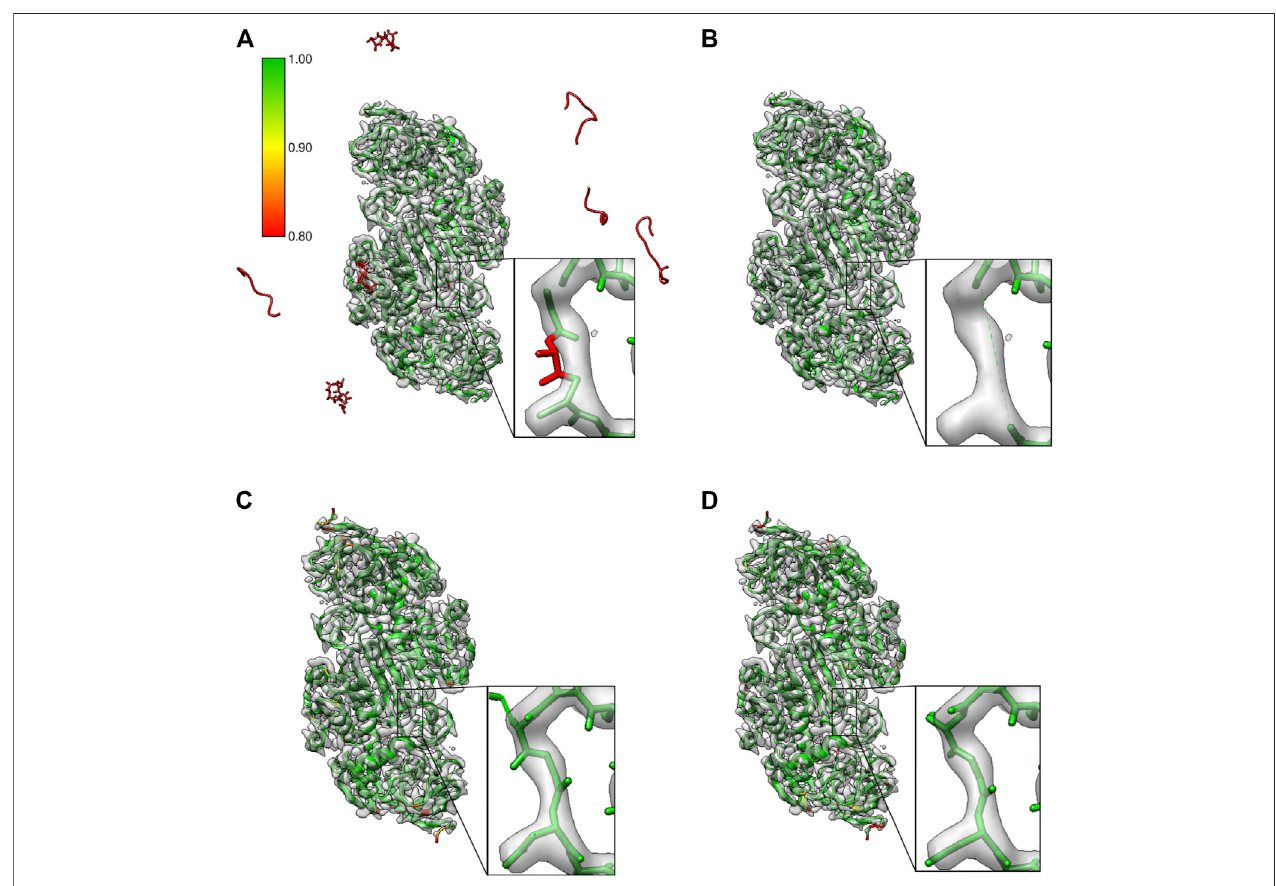
FIGURE 7 | Results from pruning the model built ab-initio with the Buccaneer software tool on the map of alcohol dehydrogenase (EMD-0406). (A) Ab-initio built model where residues associated with low con fi dence scores are in red. Potential mis fi t of residue 107 (chain A) is highlighted, and fragments built into the background noiseoutsidethemoleculardensityarealsoassociatedwithlowcon fi dencescores. (B) Modelafterpruning;themis fi ttedresidueinthechainAisremovedalongwiththe preceding and following residues (Gly106-Asn108), and fragments in the background are also removed. (C) The model T0104EM028_1 with residues in this segment with higher con fi dence scores. (D) Reference model (PDB ID: 6nbb) with the segment